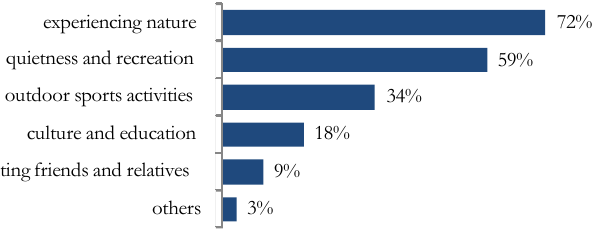
Figure 4: Motivation for recreation in the Eastern Ore Mountains (multiple responses), visitor survey (n=308)